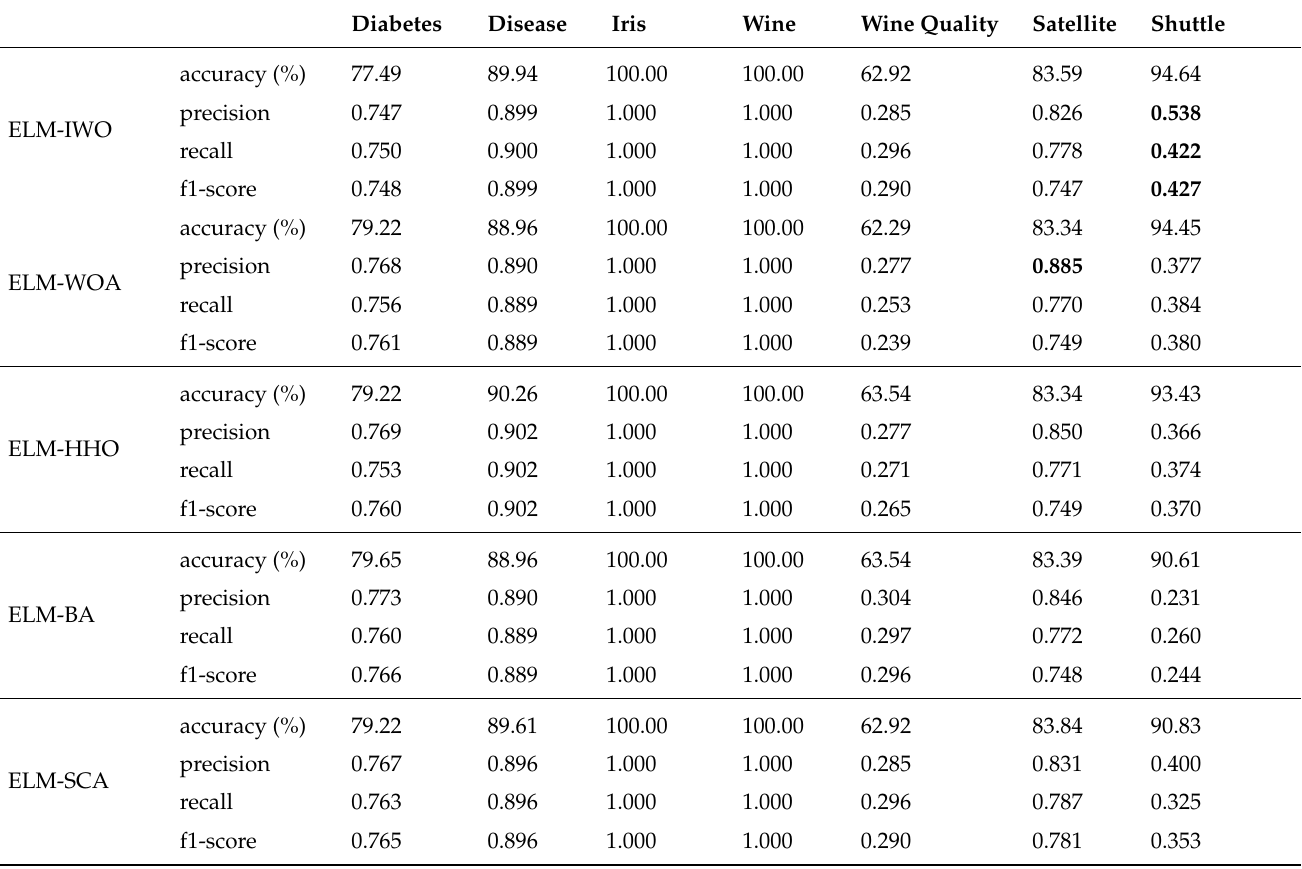
Table 6. Precision, recall, and f1-score comparative analysis for simulations with 60